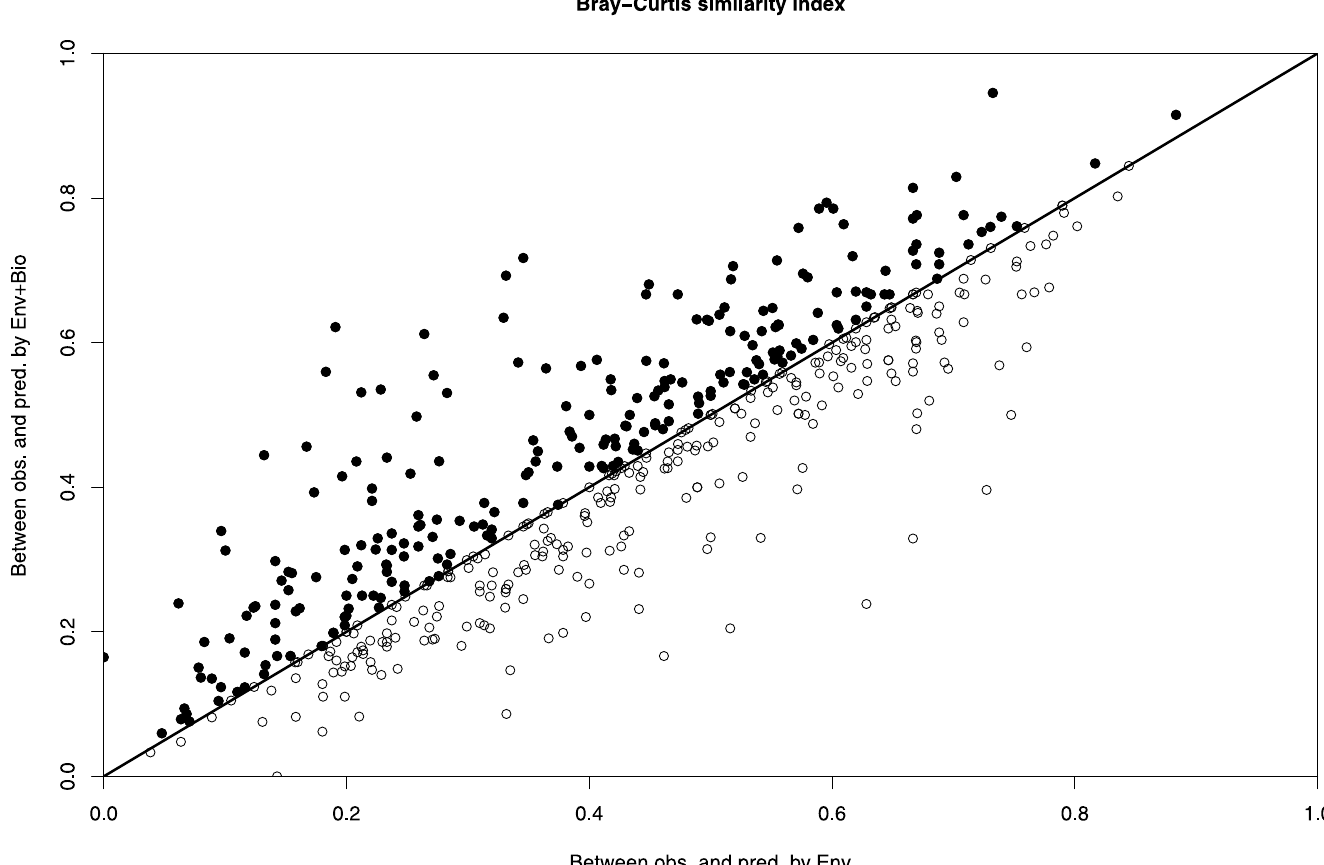
Fig 3. Correlation between the Bray-Curtis similarity index using “Env” and “Env + Bio models”. Bray-Curtis similarity index between the observed community structure and the community structure predicted by “Env+Bio” vs. the similarity index between the observed community structure and that predicted by “Env” models, for the 524 validation plots. Values of Bray-Curtis similarity index closer to 1 imply that community structure is predicted more accurately and values closer to 0 indicate less accurate predictions. Black points above the line represent plots with higher similarity between the observed values and those predicted using the “Env +Bio” rather than the “Env” predictors. The opposite is true for white points below the